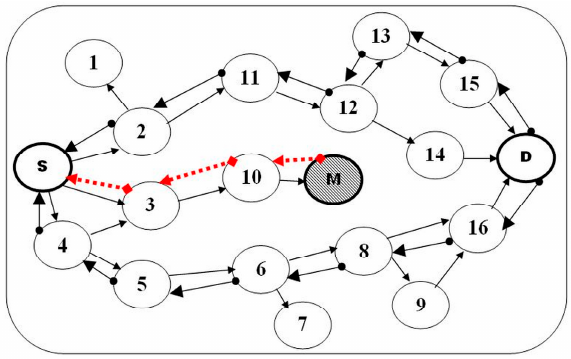
Figure 1. Sample Network